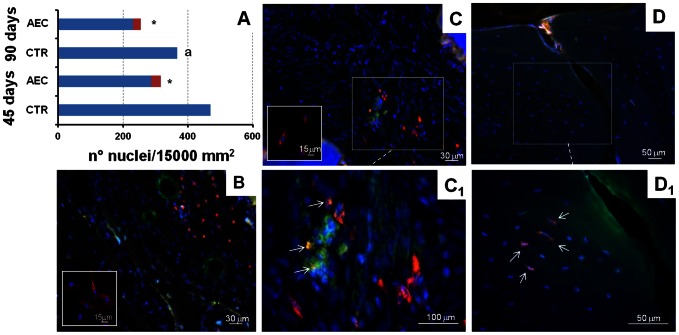
Detection of oAEC in transplanted sinuses.A) Histogram indicates the number of endogenous (blue bars) and transplanted cells (red bars) recorded in allotransplanted sinuses at 45 and 90 days p.i.. Endogenous cells or oAEC were identified by the DAPI counterstained nucleus visualized alone or surrounded by PKH26 dye, respectively. The values are expressed as mean. The SD never exceeded the 4%. * Values of total cells statistically different in oAEC vs CTR groups within the same p.i. interval, p<0.05 a Values of total cells recorded in oAEC or CTR groups significantly different when compared at 45 vs 90 days p.i., p<0.05; B) PKH26 labelled oAEC (red fluorescence) recorded in grafted sinuses at 45 days p.i.. The cells were recorded amongst fibrous matrix containing several endogenous cells identified by the bleu nuclei (DAPI fluorescence), newly deposited bone identified by the autofluorescence, blood vessels visualized by the endothelial marker, vWF (green fluorescence). Note how neither PKH26 labelled oAEC before (small box) and after transplantation express vWF. C-C1) PKH26-labelled oAEC (red fluorescence) and endogenous cells recorded in grafted sinuses at 90 days p.i.. The cells were recorded within the fibrous tissue at lower (C) and higher magnification (C1). Some of them are able to express OCN (green fluorescence), a typical bone-related protein. The OCN positivity was observed both in endogenous cells identified by the counterstained blue nuclei (DAPI) and in PKH26 positive cells (white arrows) that assume a typical orange fluorescent merge (green plus red). The PKH26 cells before transplantation did not express OCN (small box in C). D-D1) Osteocytes embedded within the newly deposited bone tissue observed at lower (D) and higher magnification (D1). The bone tissue, identified by the autofluorescence (green autofluorescence) of its matrix, showed several osteocytes. The blue nuclei (DAPI) identified the endogenous cells and the PKH26 dye displaying a typical spot fluorescence localized around the blue nuclei (arrows) identified oAEC transplanted cells.